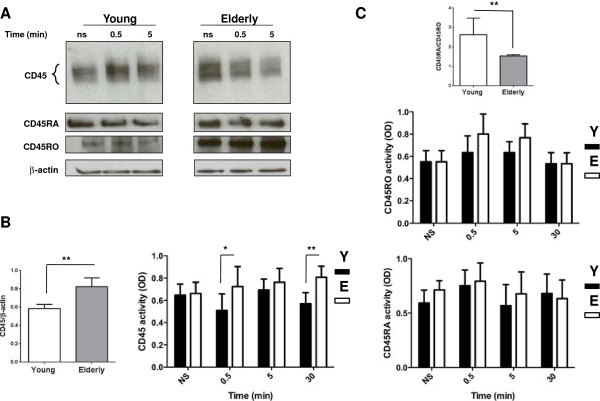
Western blot analysis and measurement of CD45 and CD45RA and CD45RO activities. (A) Purified T cells from young and elderly donors were left non-stimulated (NS) or exposed to a mixture of anti-CD3 and anti-CD28 (5 μg/ml each) mAbs for various periods of time, as indicated. Cell lysates were sized by SDS-PAGE under reducing conditions, electrotransfered to nitrocellulose membranes and proteins revealed using an anti-CD45 mAb and the chemiluminescence technique. β-Actin was used as control of gel loading. The protein transferred to nitrocellulose membranes were stained with Ponceau to verify that similar amounts of protein had been loaded in each lane. (B) Results of T cells of young (empty columns) and elderly (filled columns) donors are shown. Protein bands were analyzed by semi-quantitative densitometry and are reported in arbitrary units. Left panel shows the CD45/β-actin expression (**, p < 0.01), and right panel shows CD45 activity, in optical density units, of T cell lysate immunoprecipitates determined using 4-nitrophenyl phosphate as a substrate. Results of T cells of young (filled columns) and elderly (empty columns) donors are shown. (C) The CD45RA/CD45RO ratio in T cells from young and elderly is shown (top panel). CD45RO activity (middle panel) and CD45RA activity (bottom panel) shown in optical density units in T cell lysate immunoprecipitates determined using 4-nitrophenyl phosphate as a substrate. Results of T cells of young (filled columns) and elderly (empty columns) donors are shown. The protein transferred to nitrocellulose membranes were stained with Ponceau to further verify that similar amounts of protein had been measured for each point of activity. Data are represented as the mean ± SD. Asterisks correspond to statistical significance (Student’s t-test) for p < 0.05 (*) and p < 0.01 (**). Data are representative of one of 20 independent experiments.